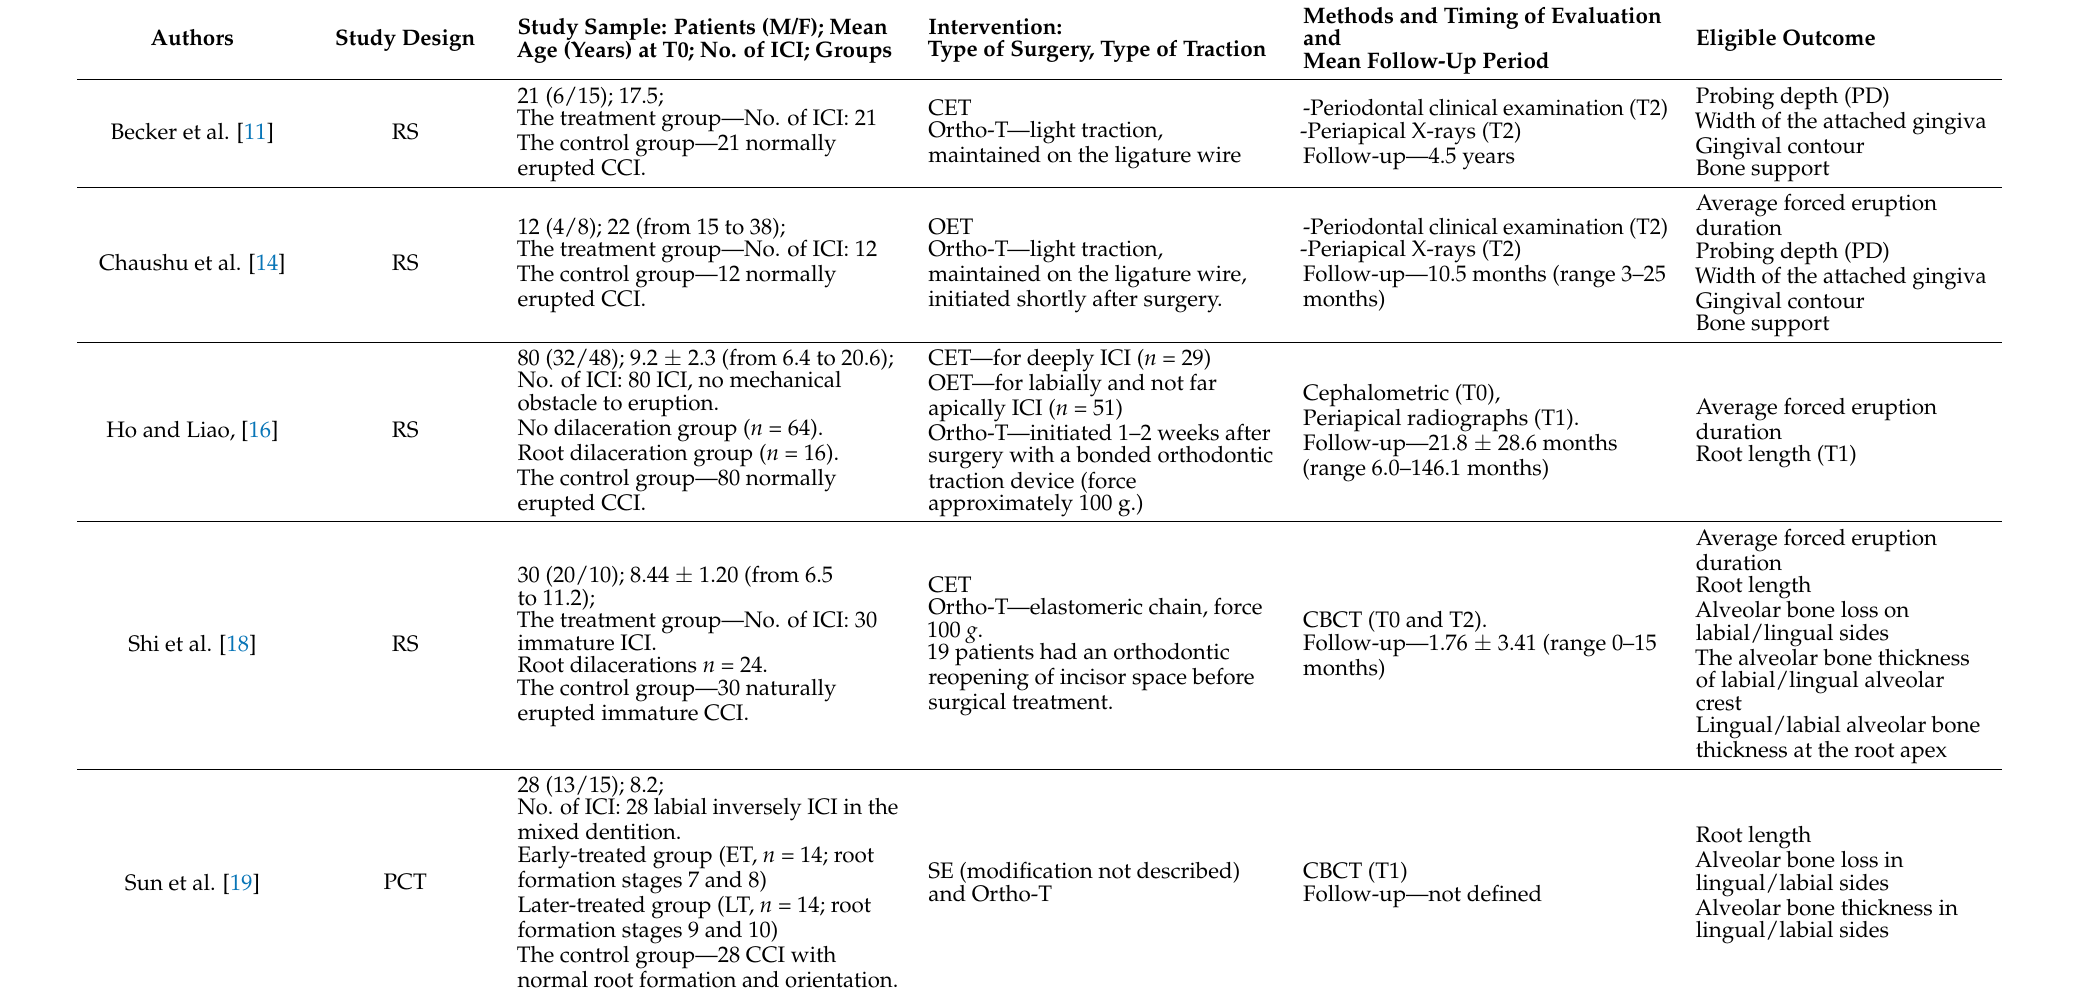
Table 1. Summary of the characteristics of included